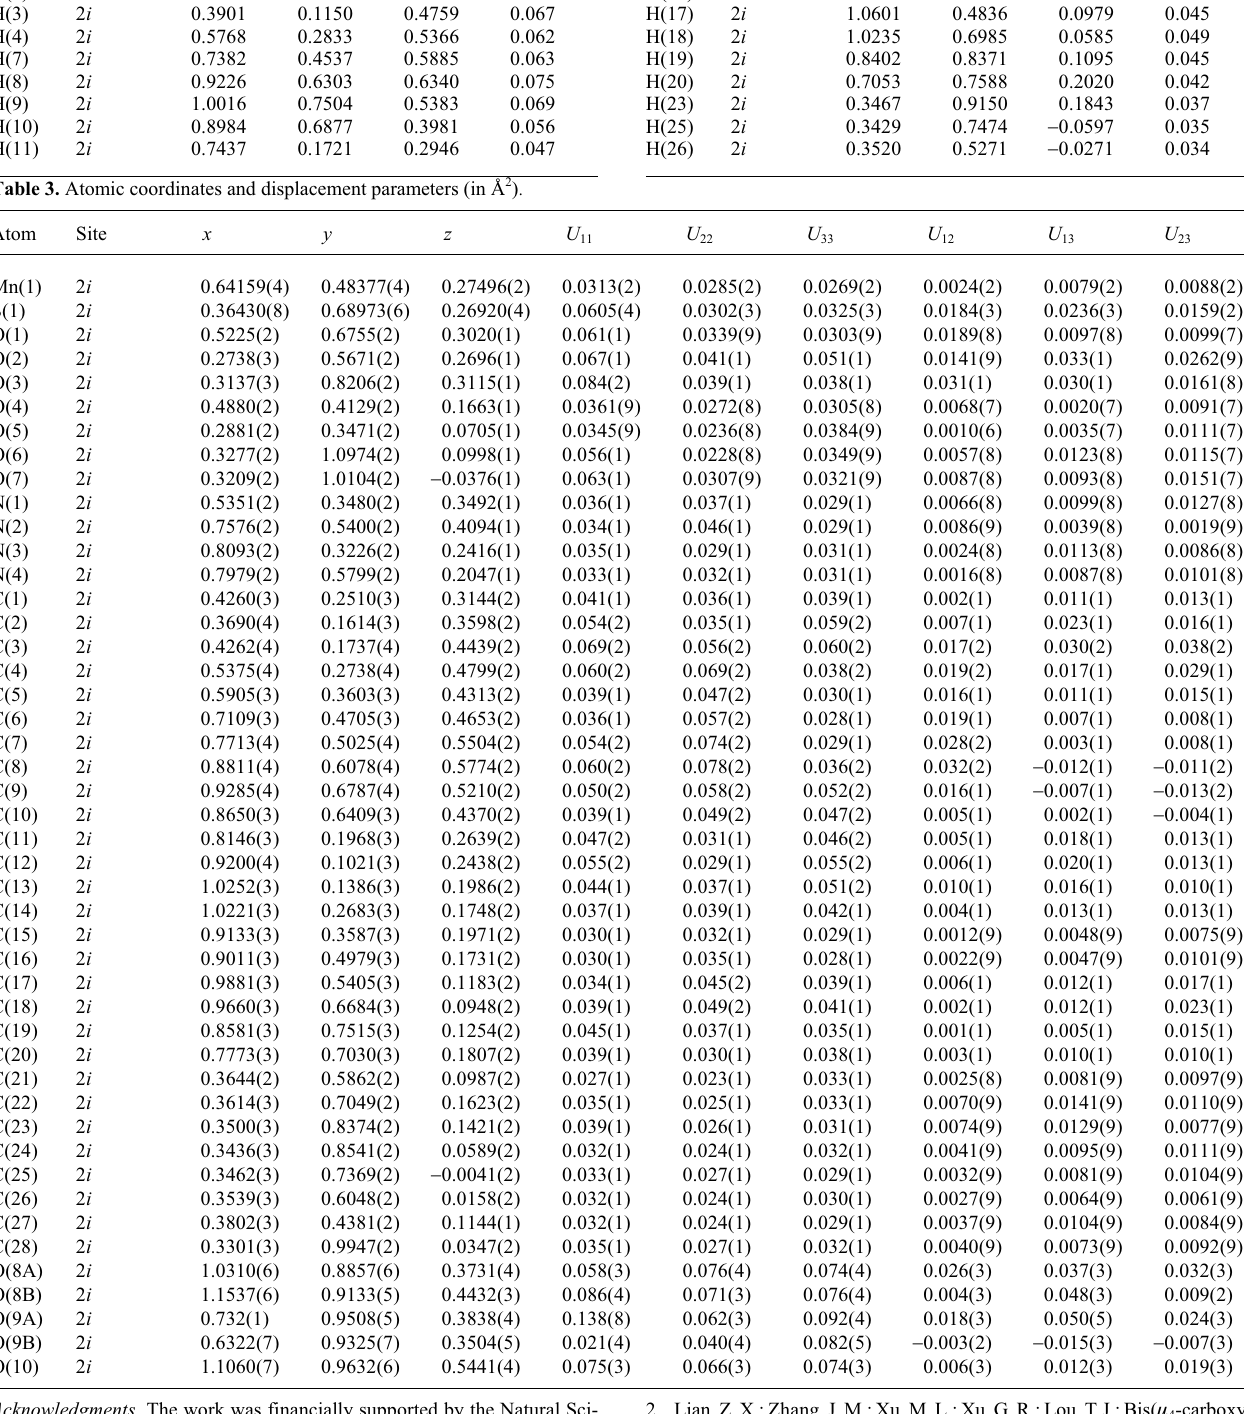
Table 2. Atomic coordinates and displacement parameters (in Å 2 ) .